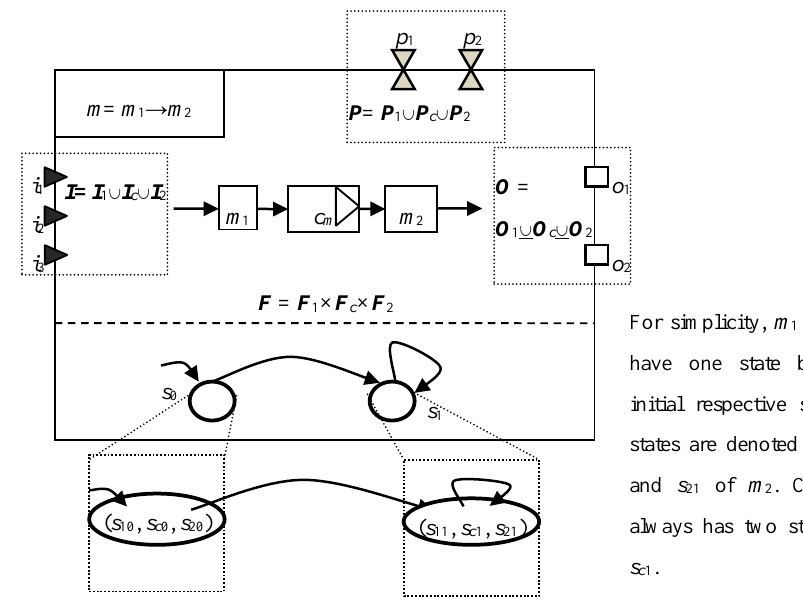
Figure 7. The diagram definition of the Sequence operator.